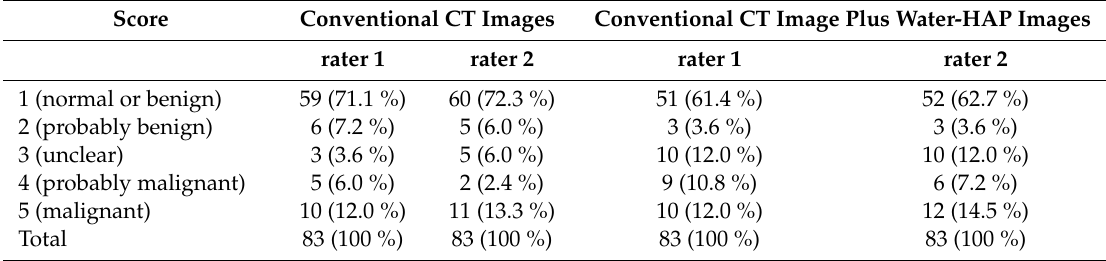
Number of cases scored on conventional CT images and conventional CT images plus